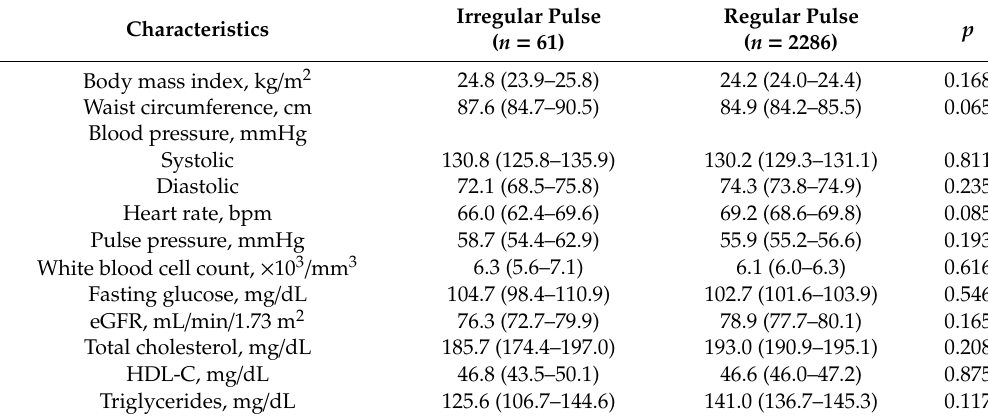
Table 2. Clinical data.